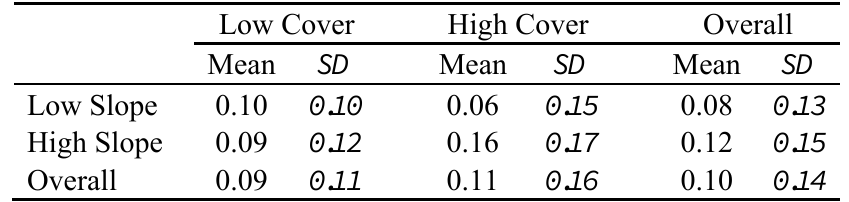
Table 3. Mean and standard deviation for signed vertical error (m) for elevation checkpoints in four slope and canopy cover groups.